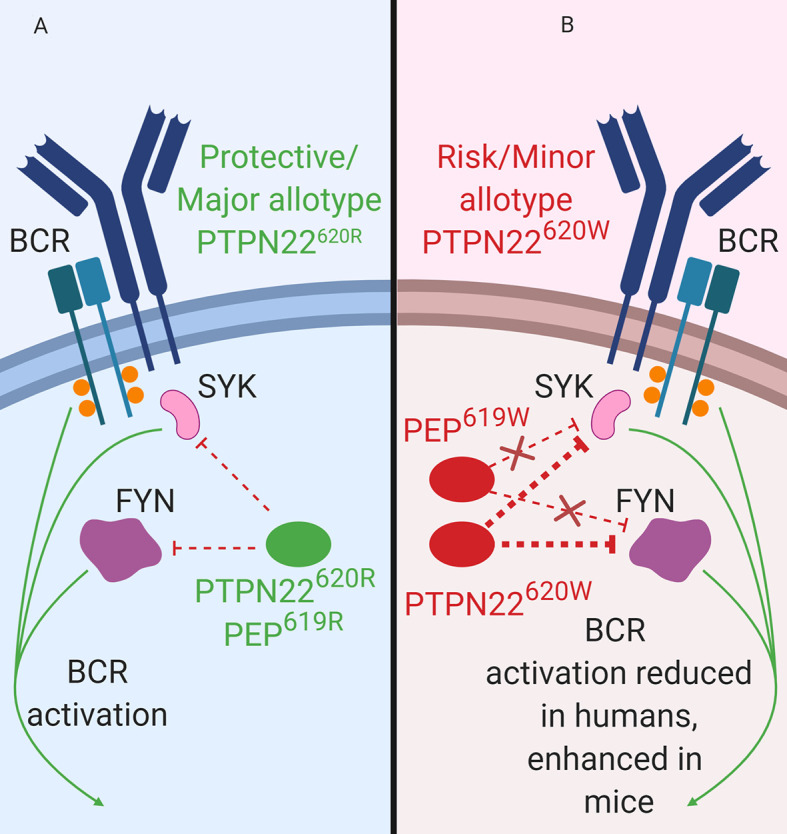
PTPN22 function in B cells. (A) PTPN22620R and PEP619R are negative regulators of BCR signaling in B cells. (B) PTPN22620W is a gain-of-function variant with respect to BCR signaling and leads to blunted BCR signaling. PEP619W is a loss-of-function variant with respect to BCR signaling and leads to enhanced BCR signaling.